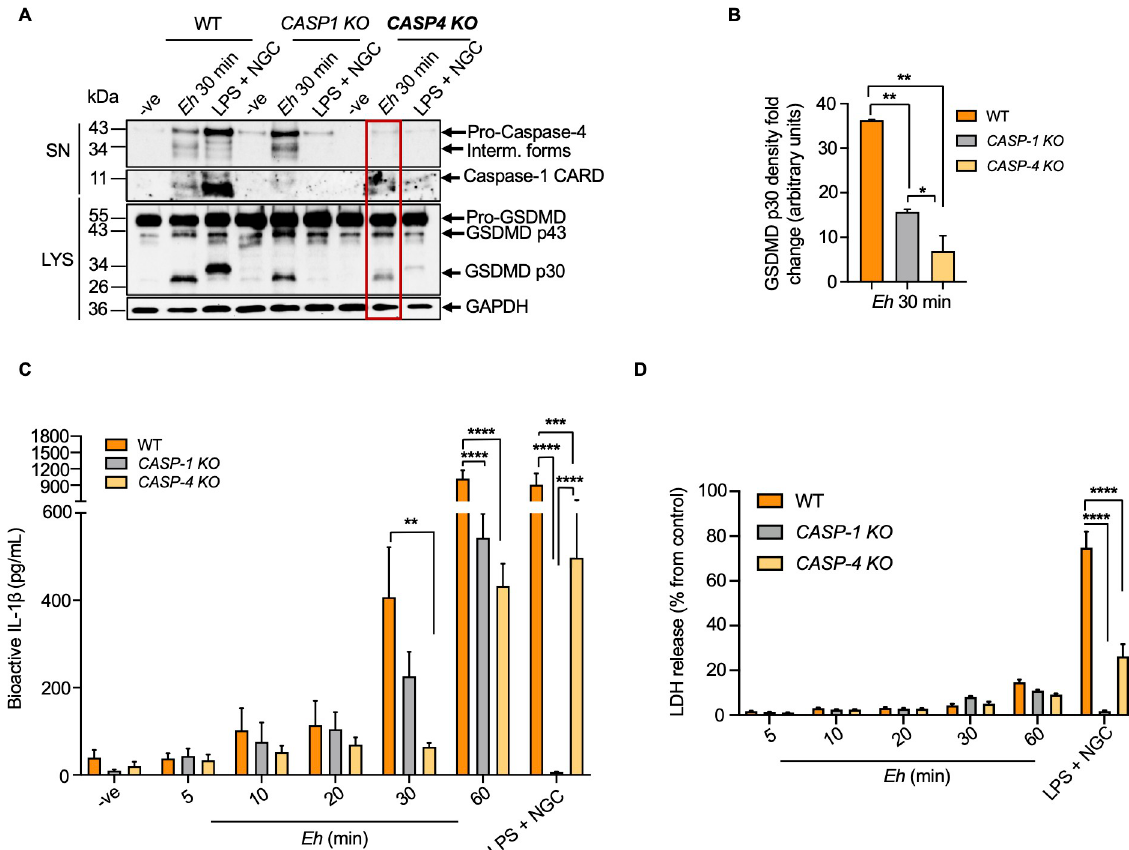
Fig 7. Dependency for E . histolytica -induced caspase-4 in gasdermin D cleavage and bioactive IL-1 β release. ( A ) WT, CRISPR/Cas9 CASP1 KO and CRISPR/Cas9 CASP4 KO macrophages were incubated with Eh for 30 min or the positive control LPS (50 ng/mL) and NGC (10 μ M) for 60 min. Cell supernatant (SN) was TCA precipitated and cells were washed and lysed. Equal amount of supernatants and lysates (LYS) was loaded onto SDS-PAGE and immunoblot analysis was performed for caspase-4 and caspase-1 secreted to the supernatants and along with GSDMD p30 pore-forming fragment in lysates, and blots were reprobed for GAPDH. ( B ) Quantifications of cleaved GSDMD were performed by densitometric analysis from three independent experiments, and the negative (cells only) acted as an internal control. ( C ) Cell supernatant was added to HEK-Blue reporter cells to detect bioactive IL-1 β by measuring SEAP. ( D ) THP-1 cell supernatant was assessed by the release of LDH following Eh stimulation and normalized to non-stimulated negative controls (basal cell death). Data and immunoblots are representative of at least three independent experiments (n = 3) and statistical significance was calculated with ANOVA and Bonferroni’s post- hoc test between WT and KO macrophages and between CASP1KO and CASP4 KO macrophages at each time point. ( � p < 0.05, �� p < 0.01, ��� p < 0.001, ���� p < 0.0001). Bars represent mean ±